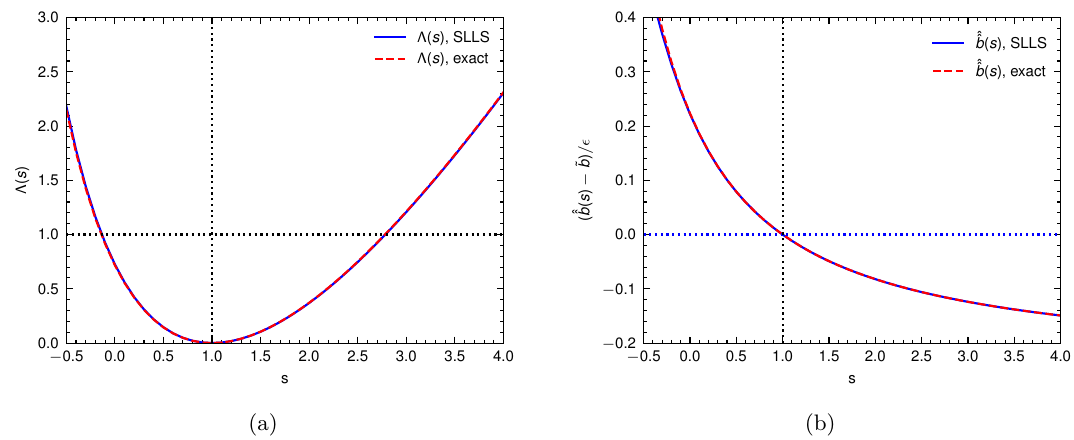
ˆˆ b ( s ) for a range of values of the signal